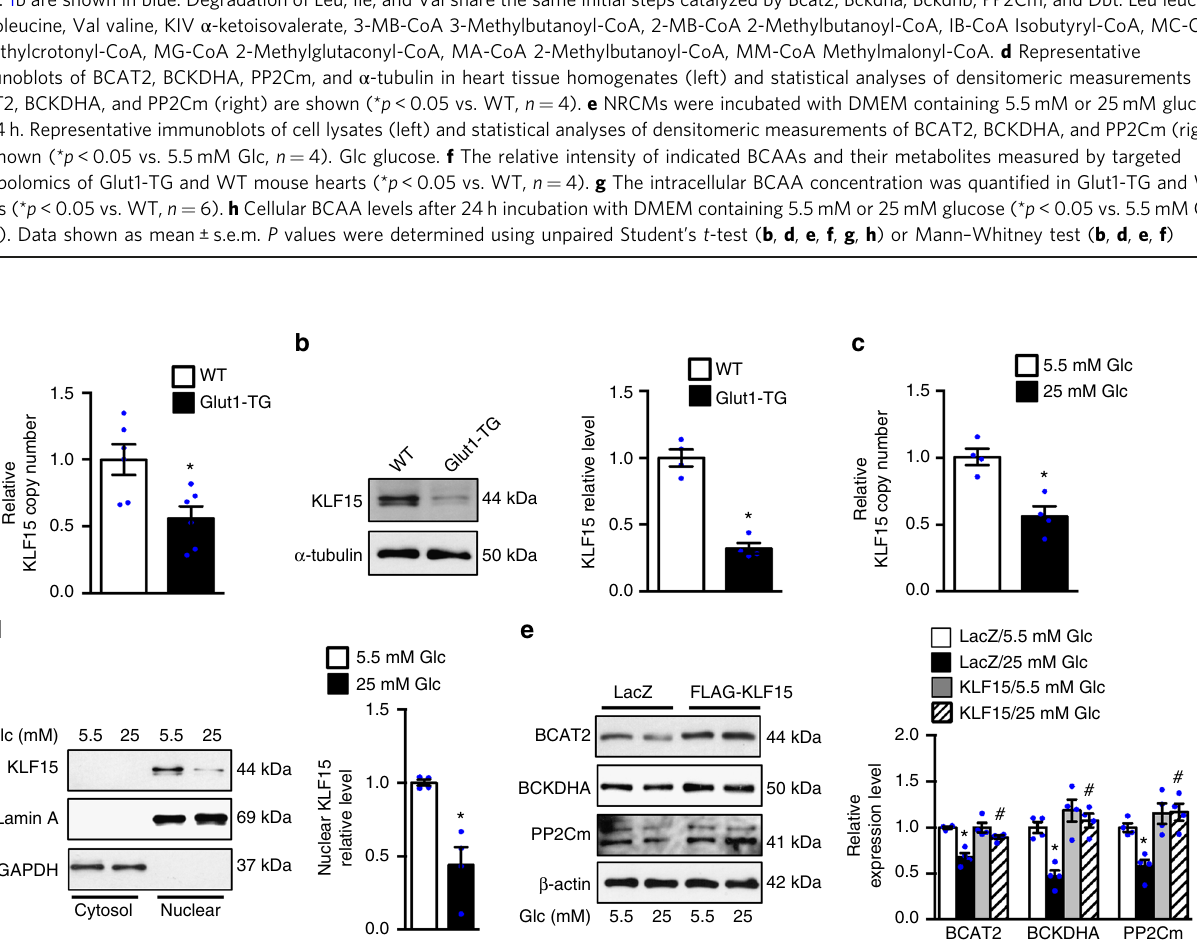
Fig. 2 KLF15 is essential for glucose-mediated downregulation of BCAA degradation. a qRT-PCR analysis of KLF15 mRNA in Glut1-TG and WT hearts. The expression was normalized to 18S rRNA and reported as fold change over WT (* p < 0.05 vs. WT, n = 6). b Representative immunoblots of KLF15 and α - tubulin in heart tissue homogenates (left) and statistical analysis of densitomeric measurement of KLF15 (right) are shown (* p < 0.05 vs. WT, n = 4). c The mRNA level of KLF15 in NRCMs incubated with DMEM containing 5.5 mM or 25 mM glucose for 24 h (* p < 0.05 vs. 5.5 mM Glc, n = 4). d NRCMs were incubated with DMEM containing 5.5 mM or 25 mM glucose for 24 h. Representative immunoblots from cytosolic and nuclear fractions (left) and statistical analysis of densitomeric measurement of nuclear KLF15 (right) are shown (* p < 0.05 vs. 5.5 mM Glc, n = 4). e NRCMs transduced with indicated adenovirus were incubated with DMEM containing 5.5 mM or 25 mM glucose for 24 h. Immunoblots of cell lysates (left) and statistical analyses of densitomeric measurements of BCAT2, BCKDHA, and PP2Cm (right) are shown (* p < 0.05 vs. LacZ/5.5mM Glc, # p < 0.05 vs. LacZ/25 mM Glc, n = 4).